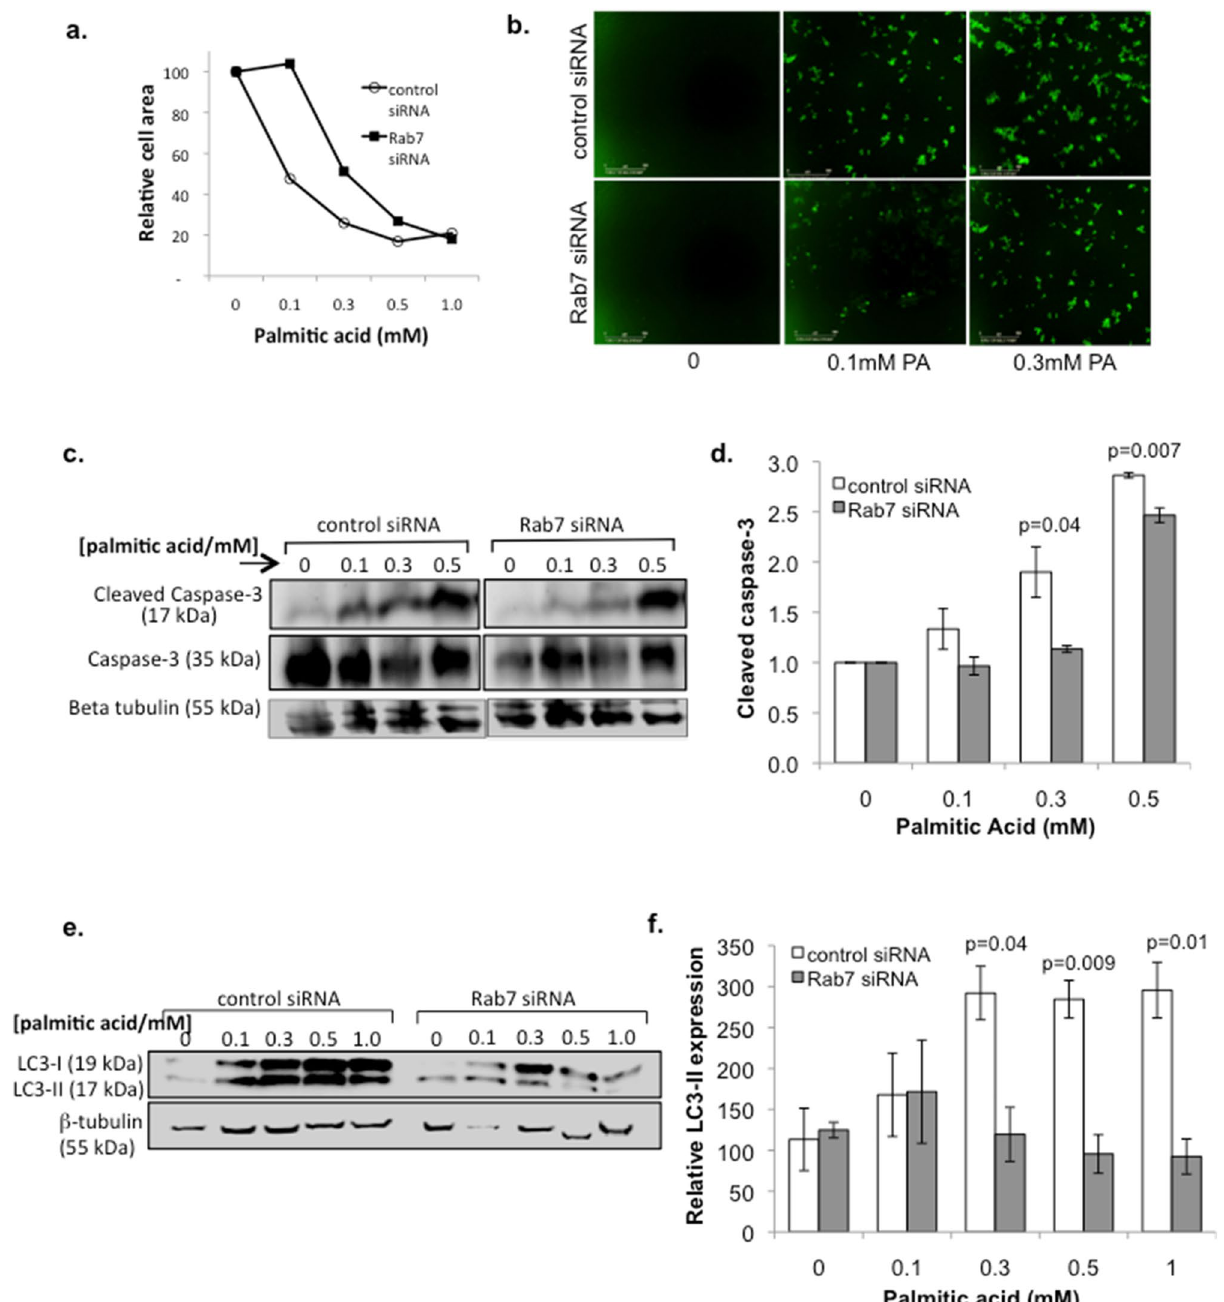
Figure 6. Rab7a attenuation protects against metabolic stress-induced beta cell death. INS-1 cells were treated with control- or Rab7a-siRNA for 3 days, then treated with the indicated concentration of palmitic acid (PA). ( a ) Cells were imaged using an IncucyteZoom system to determine cell area. ( b ) Representative images using 5 µM of Caspase-3/7 apoptosis reagent (Essen bioscience), which shows caspase-3/7 activation. Scale bar = 300 µm. ( c ) Cell lysates were prepared and analysed by western blot to quantify the amount of active (17 kDa) and inactive (35 kDa) Caspase-3. Representative blots are shown. ( d ) Relative mean expression of active caspase-3 is shown from three independent experiments. ( e , f ) Western blot analysis was used to determine expression of the autophagy marker LC3-I/II, with representative blots shown in ( e ), and relative mean expression of LC3-II from three independent experiments shown in ( f ). Values standardised to untreated control siRNA sample. Error bars indicate SEM, and Students’ t-test was used for statistical